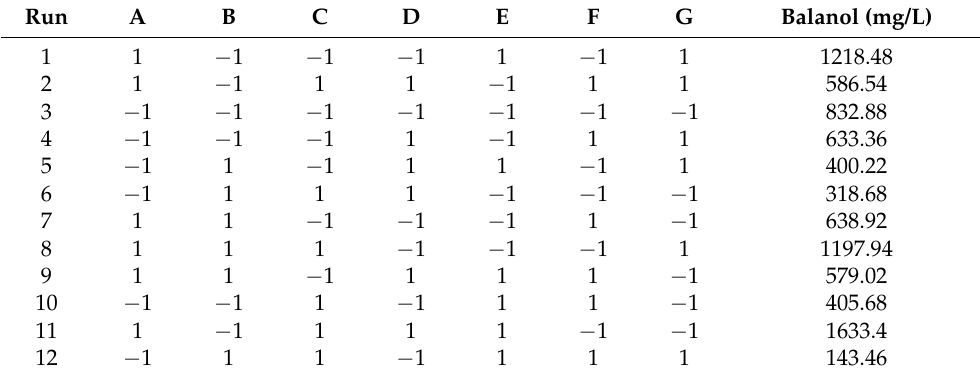
Table 1. PB experimental design and observed balanol